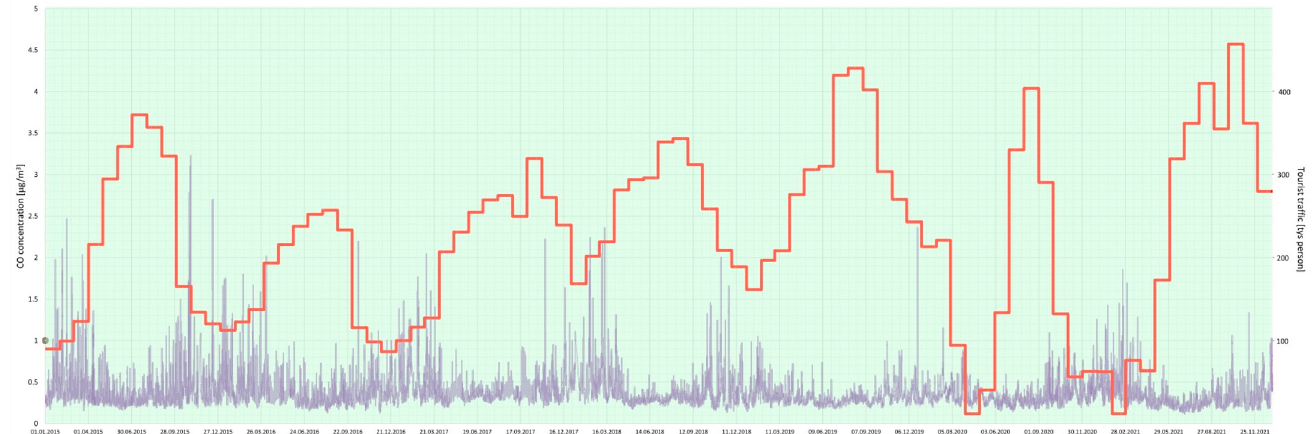
Figure 9. CO concentration in relation to tourist traffic (the Gda ń sk agglomeration, years 2015–2021). Source: own study.